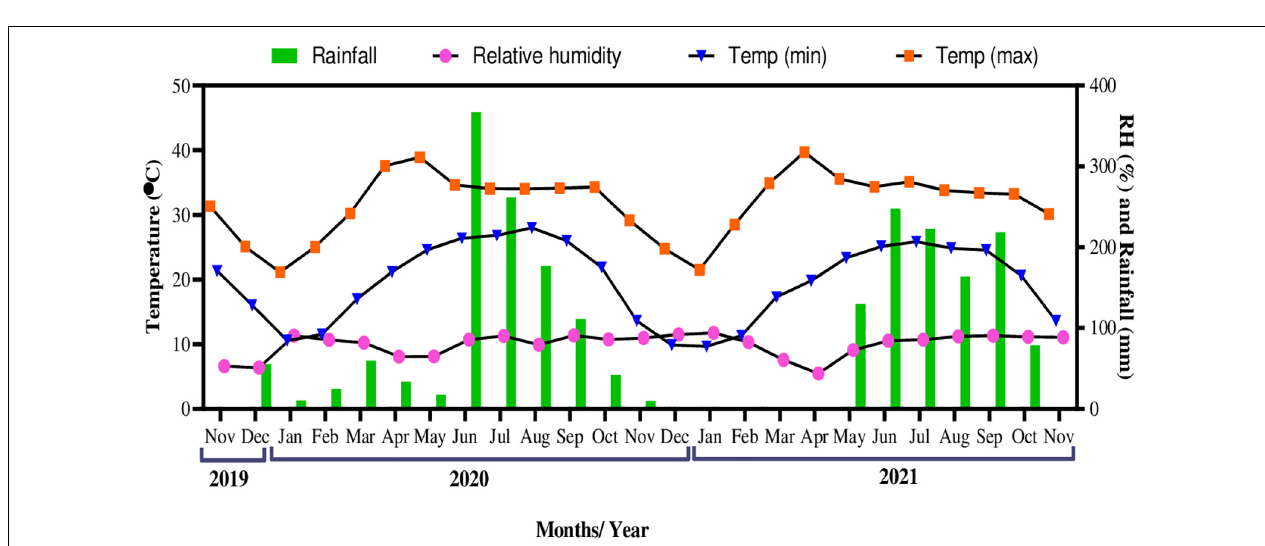
FIGURE 1 | Representation of experimental setup: (A) the experimental field with test plant, (B) schematic representation of the field. The design is a split plot with a random plantation. The abbreviations for treatments are: C, control PM; A, ambient PM; and E, elevated PM.